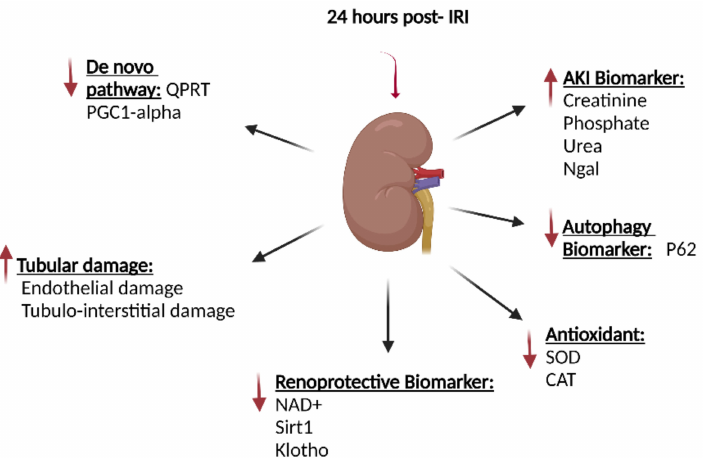
Figure 2. Alternated NAD + related pathways in IRI-induced AKI rats after 24 h. The IRI-induced AKI resulted in a significantly elevated creatinine, phosphate, and urea and an increase in the Ngal , all biomarkers for AKI. The tubular damage is also observed at 24-h post-IRI. This model showed a significant decrease in the biomarkers for renal health, NAD + , Sirt1 , Klotho, and antioxidants such as Sod2 and Cat . Qprt and Pgc1- α were also downregulated in this model, the two genes involved in the de novo biosynthesis pathway. An elevated level of P62 is also observed, a biomarker for autophagy. IRI: ischemia-reperfusion injury; AKI: acute kidney injury; Ngal : neutrophil gelatinase-associated lipocalin; Sirt1 : Sirtuin1; Sod2 : superoxide dismutase; Cat : catalase ; Qprt : quinolinate phosphoribosyl- transferase; Pgc1- α : peroxisome proliferator-activated receptor-gamma coactivator-1